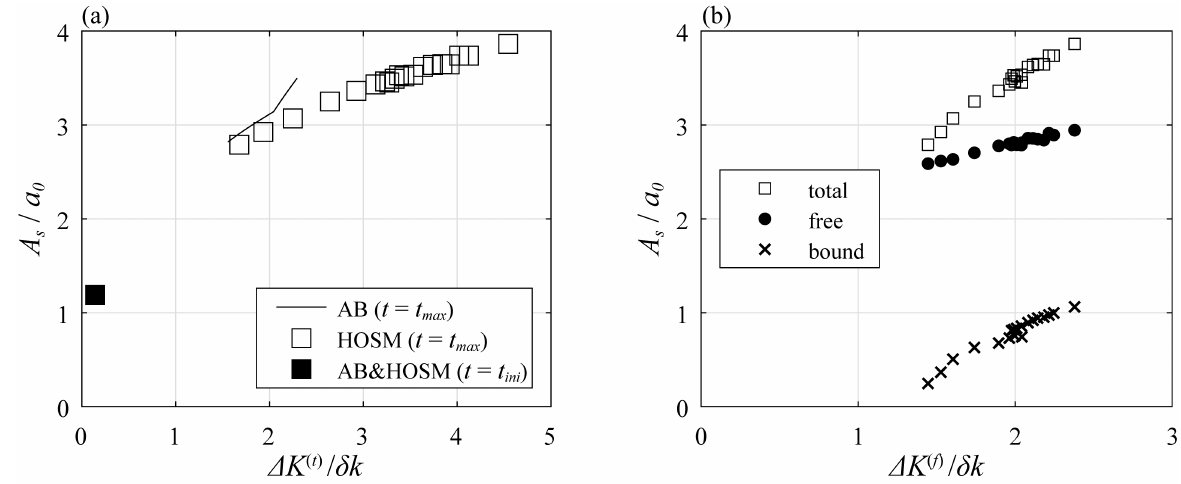
Figure 11. ( a ) Relation between the spectral broadening ∆ K / δ k and amplitude sum A s / a 0 of the mod- ulated wave train. ( b ) Relation between the free-wave spectral broadening ∆ K ( f ) / δ k and amplitude sum A s / a 0 of the modulated wave train for the total, free-wave, and bound-wave components. To clarify the individual contributions of each wave type to A s , A s / a 0 for the free and bound waves together with that for the total wave are plotted against ∆ K / δ k in Figure